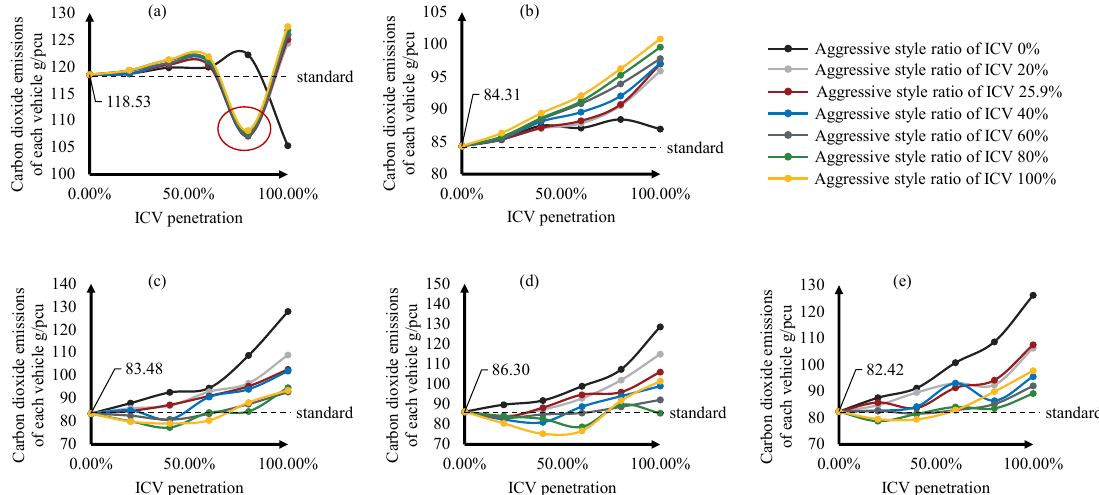
Figure 9. The impacts of SLADS on the average CO 2 emissions per vehicle of the secondary motorway under different driving styles with the volume input being equal to the first service level ( a ), the third service level ( b ), the saturated service level ( c ), and the 20% ( d ) and 40% ( e ) oversaturated service level.